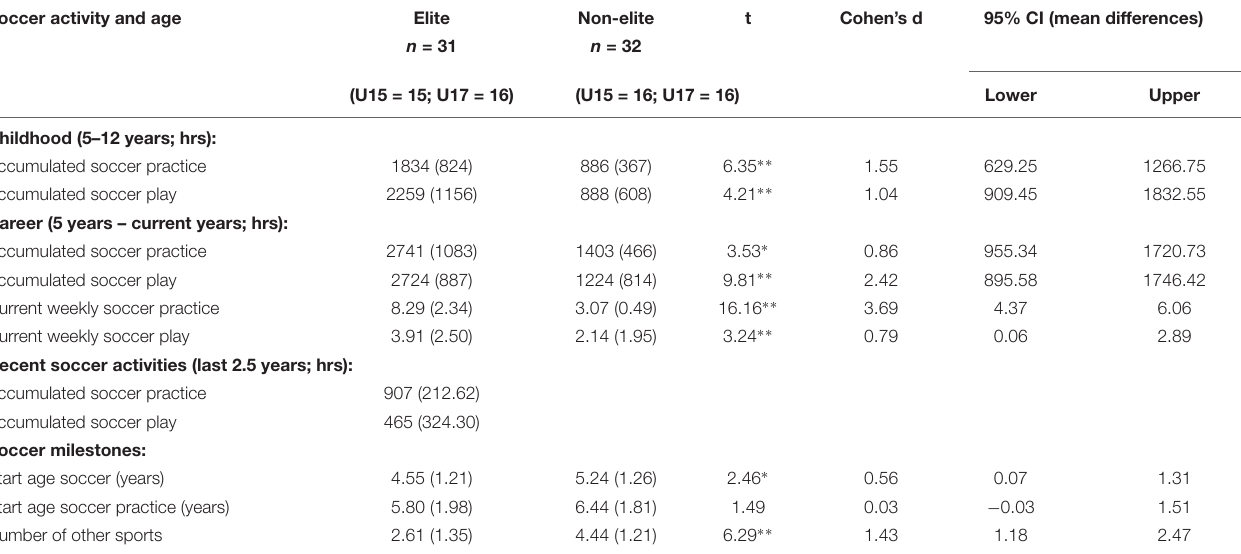
TABLE 1 | Means, (SDs) and 95% confidence intervals corresponding to accumulated and weekly hours in practice and play (during childhood and across the player’s careers) for the elite and non-elite groups, as well as start age in soccer activities and number of sports participated in childhood. Soccer activity and